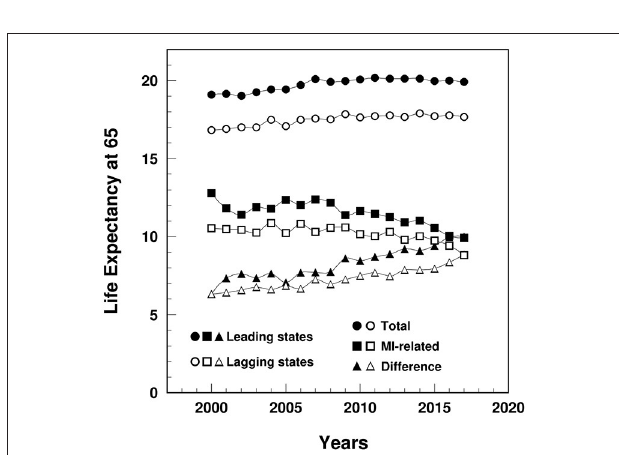
FIGURE 4 | Temporal trend of 1-, 3-, and 5-year survival after a MI diagnosis among people aged 65 + in the U.S. leading and lagging states. Note: Data were derived from 5% sample of Medicare Beneficiaries.